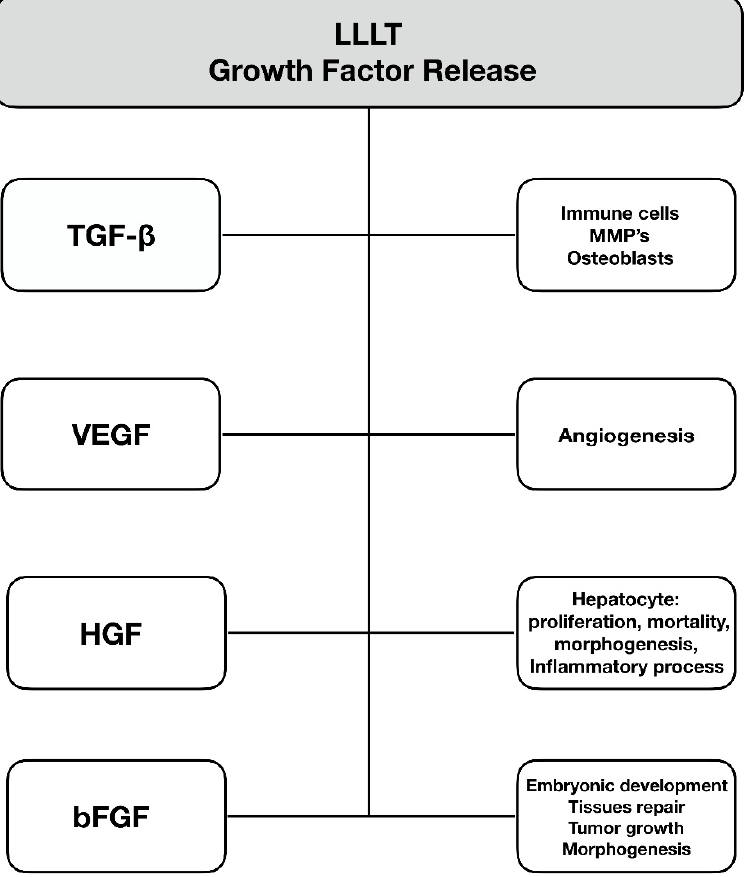
Figure 5. Changes in growth factor activity after low-level laser therapy.